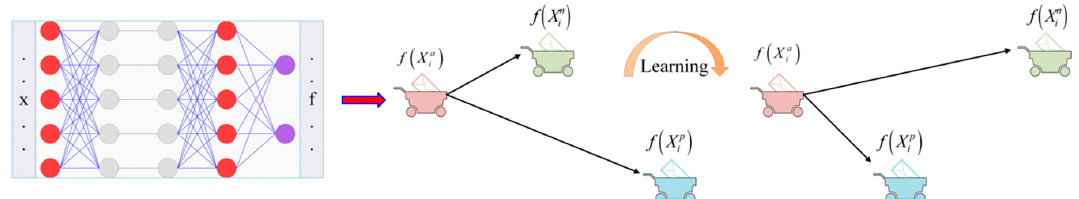
Figure 4. Learning machine of triplet loss network. The triplet loss minimizes the distance between an anchor and a positive, both of which have a normal data sequence, and maximizes the distance between the anchor and a negative of an abnormal data sequence. Where f data, positive data and negative data,